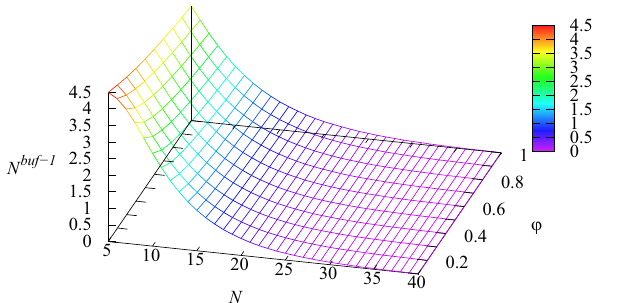
Figure 4. Dependence of the mean number of requests N buf − 1 in the first buffer on ϕ and N .